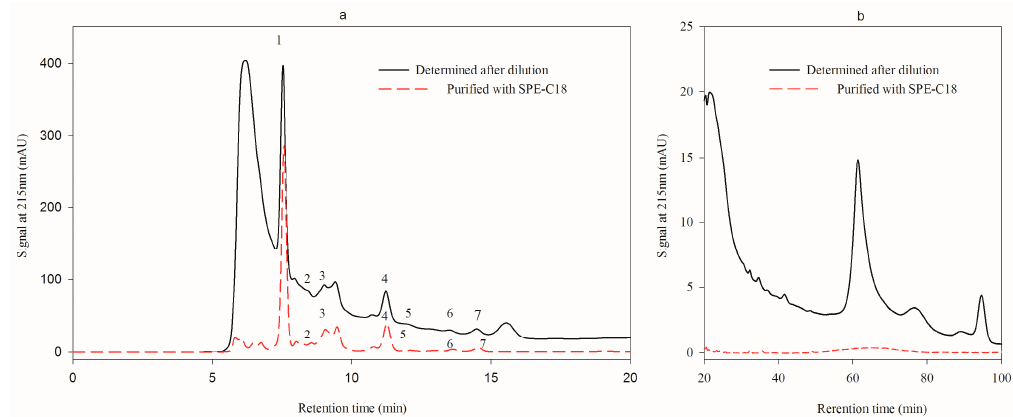
Figure 3. E ff ect of LC-18 SPE tube pretreatment on the analysis of HPLC method 1 ( a ), chromatogram of the first 20 min elution, Peak 1, 2, 3, 4, 5, 6 and 7 were citric acid, pyruvic acid, l -malic acid, succinic acid, lactic acid, fumaric acid, and acetic acid; ( b ), chromatogram of the 20–100 min elution.